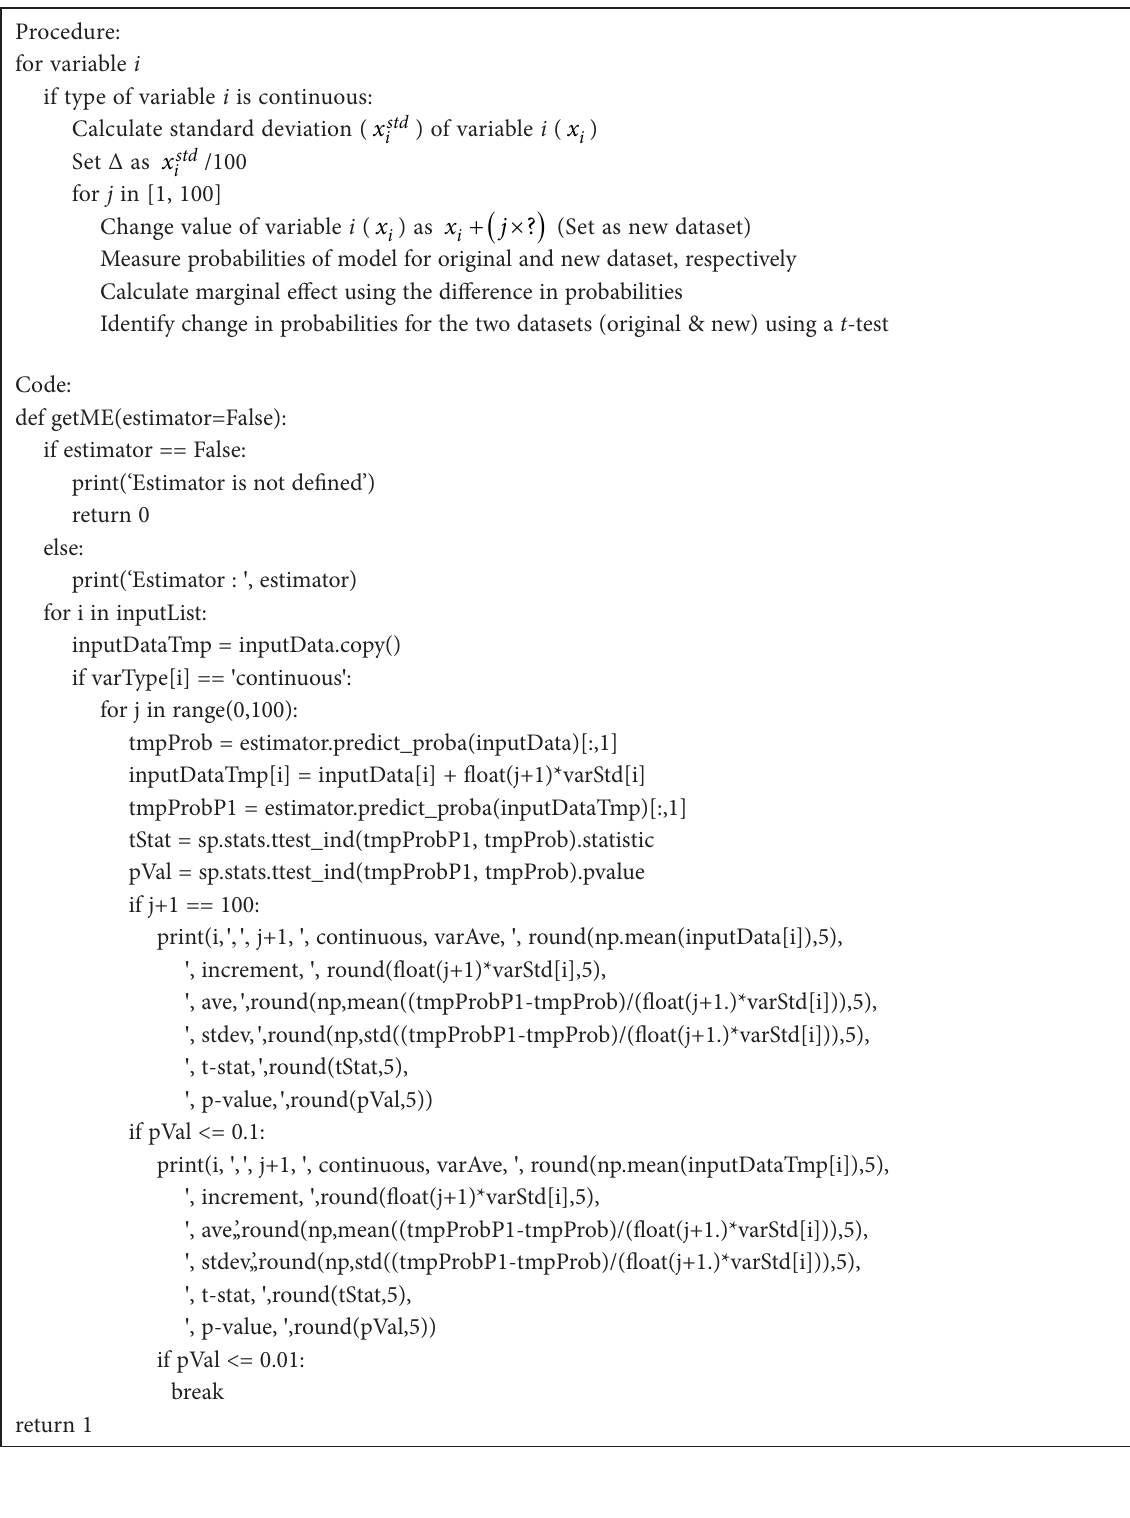
Algorithm 1. Algorithm for ME